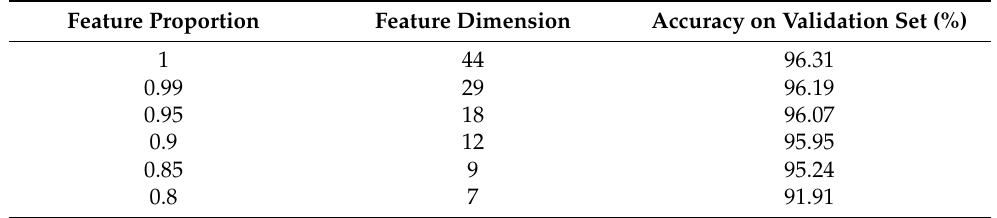
Table 5. The process of dimensionality reduction using PCA.